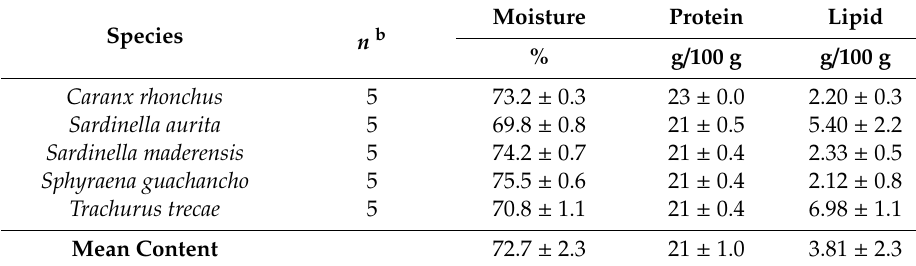
Table 3. Analytical values of the proximate composition of fish species from Angola a . Species n b